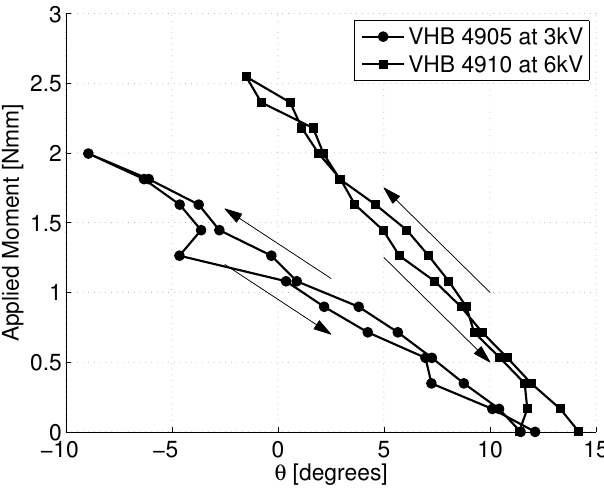
Figure 8. The angle versus applied moment for the bender shown in Figure